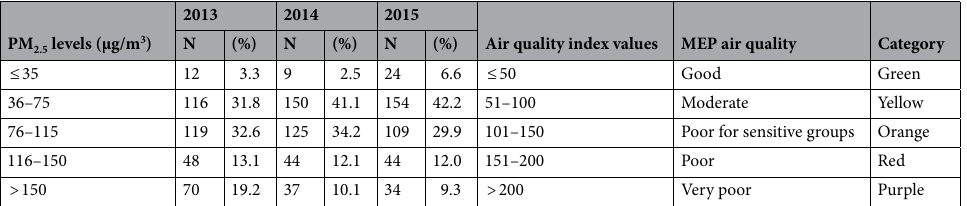
Table 2. PM 2.5 levels and air quality index values in Jiang, China, from 2013 to 2015.